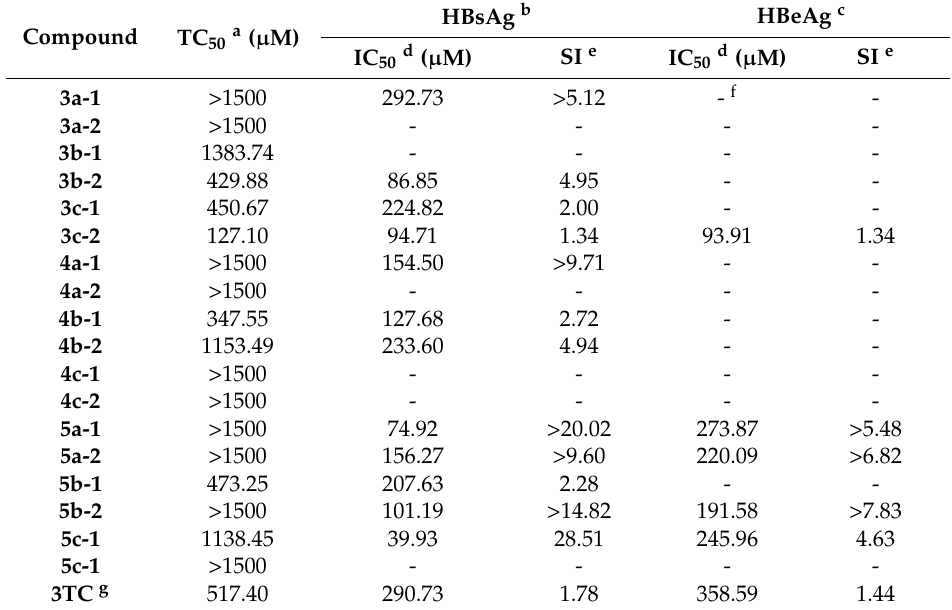
Table 2. Inhibition on the secretion of HBsAg, HBeAg and cytotoxicity of compounds in 9 days.